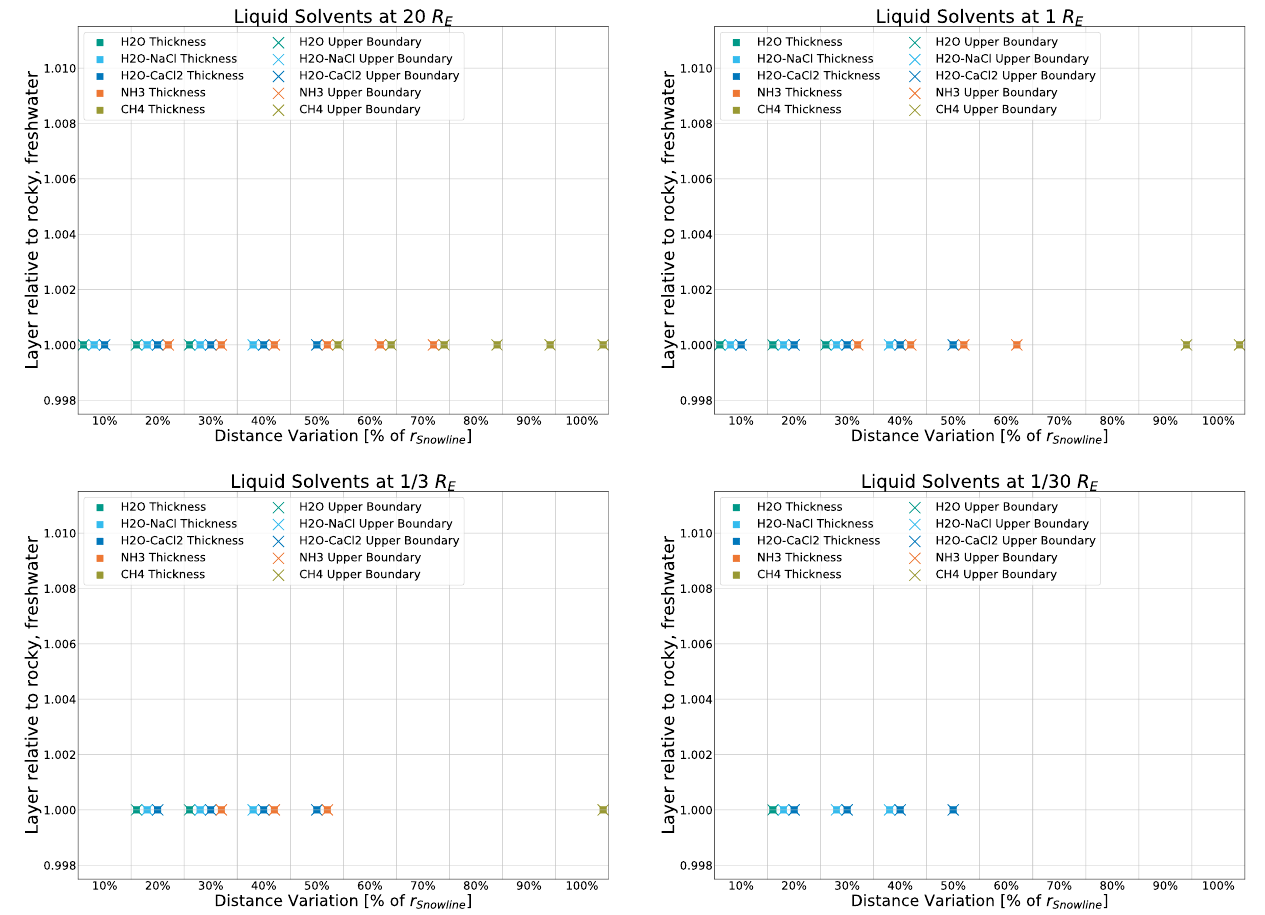
Figure A7. Deviation from the rocky, freshwater model (with input being the average spectrum of 20 AGNs) for a simulation with input coming from a single, strong source (Mrk 876).